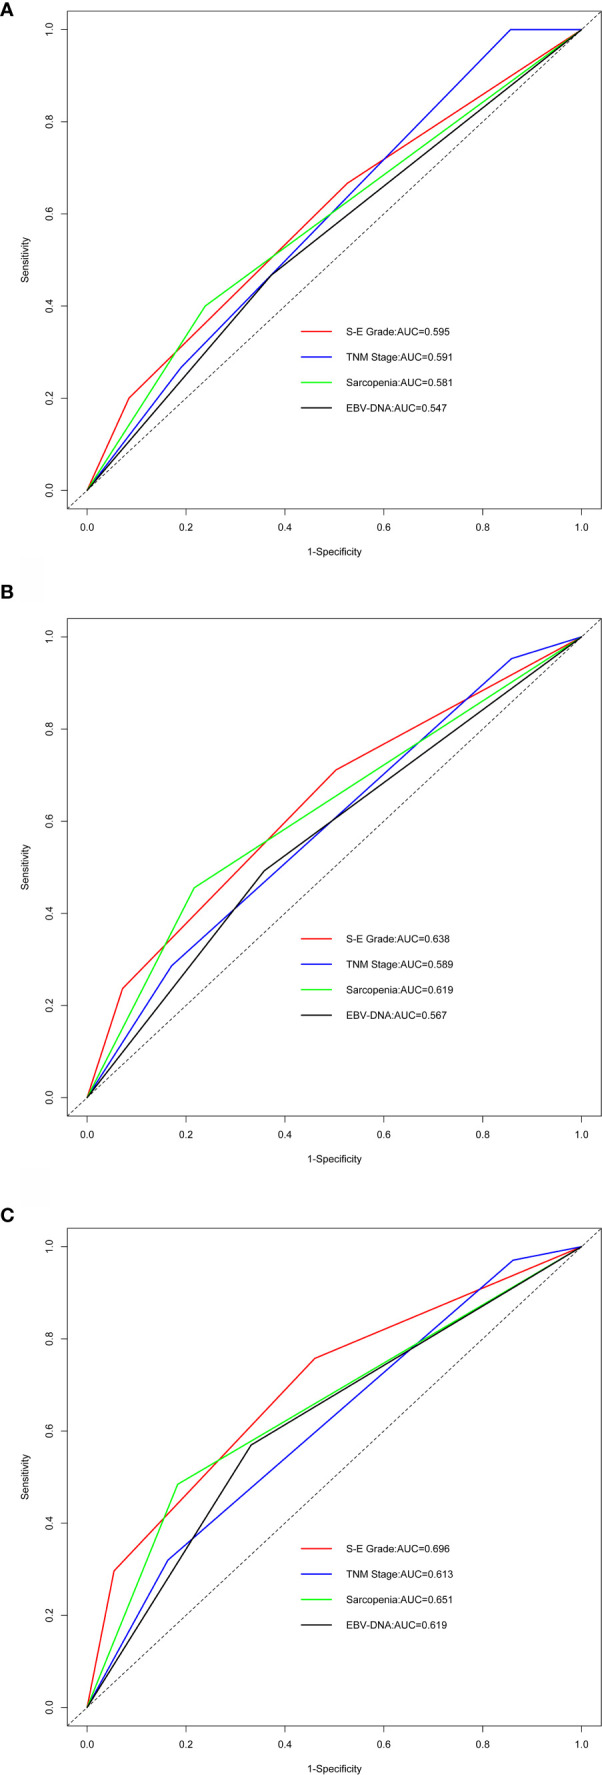
Comparing predictive ability by time-dependent receiver-operating characteristic curve (tROC) analysis. EBV-DNA = Epstein-Barr virus DNA; S-E grade = sarcopenia EBV-DNA grade; AUC = area under the receiver-operating characteristic curve. (A–C) Time-dependent ROC analysis for 1-, 3-, and 5-year OS, the x-axis represents the sensitivity value (true positive rate), and the y-axis represents the 1-specificity (false positive rate). The larger AUC implies that patients can obtain the maximum prediction using this model.